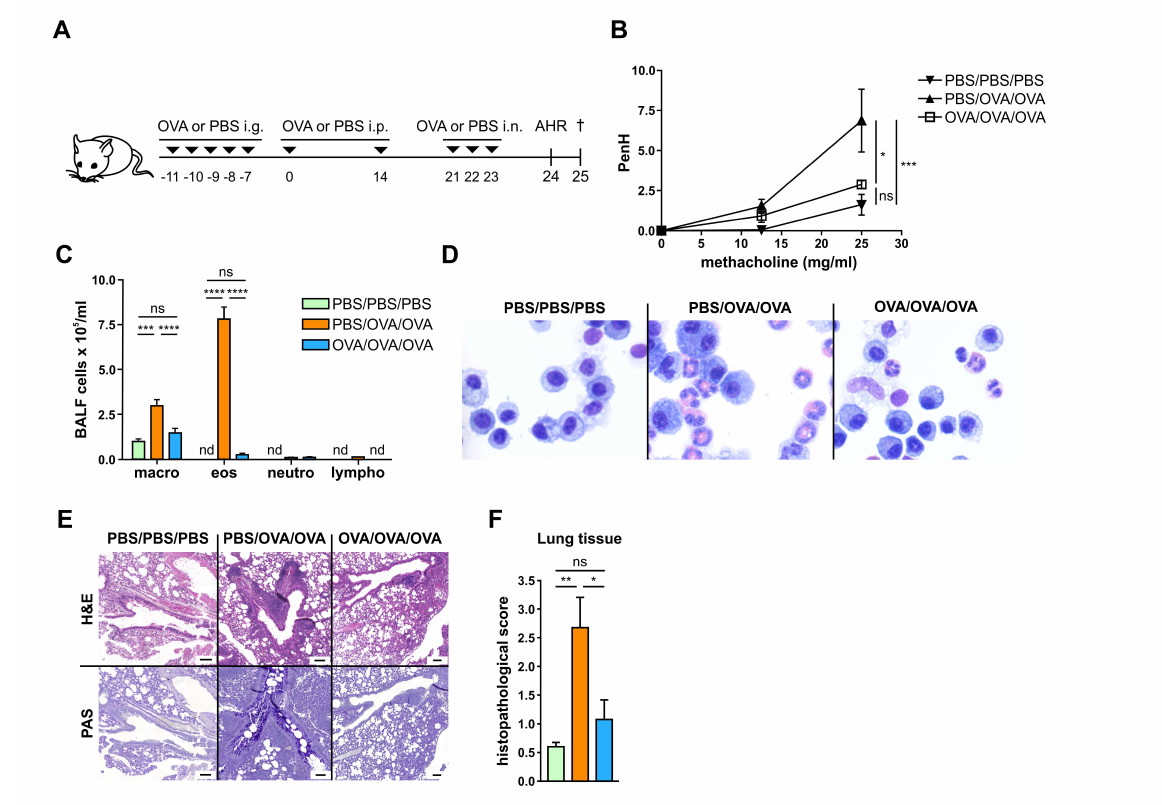
Figure 1. Prophylactic oral treatment with ovalbumin (OVA) leads to the induction of tolerance. ( A ), Experimental design. i.g., intragastric; i.p., intraperitoneal; i.n., intranasal; PBS, phosphate-bu ff ered saline. ( B ), airway hyperresponsiveness (AHR) in response to methacholine. PenH, enhanced